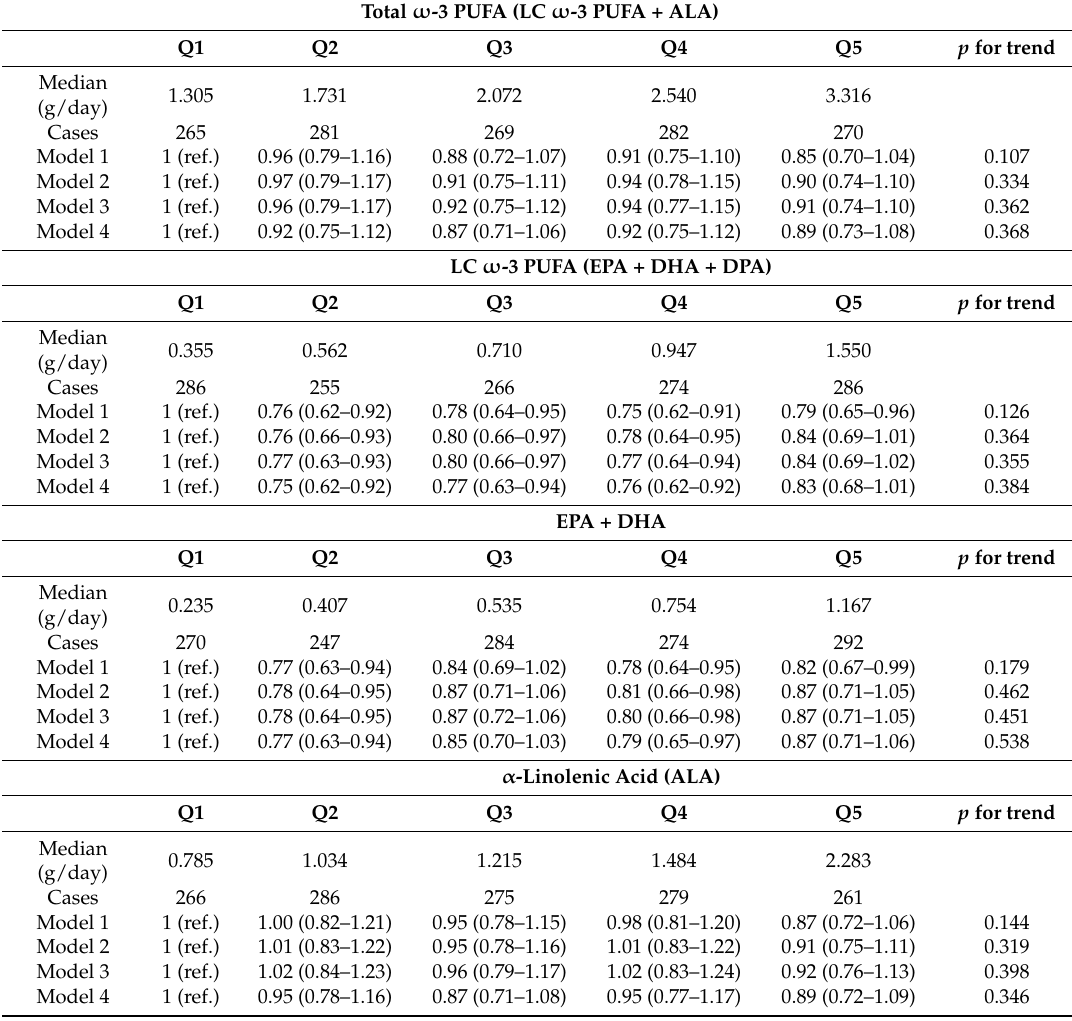
Table 3. OR and 95% CI for the association between energy-adjusted omega-3 fatty acid intake (quintiles) and life-time prevalence of depression in the PREDIMED-Plus